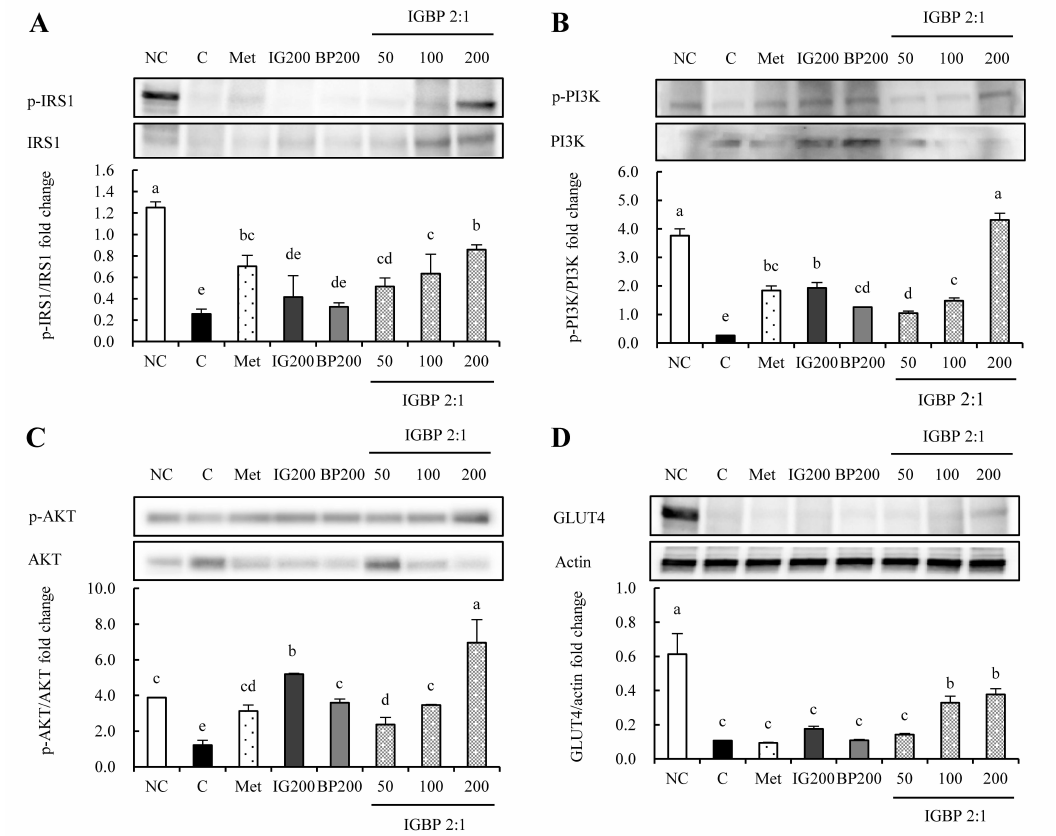
Figure 3. E ff ects of the IGBP 2:1 mixture on GLUT4 signaling-related proteins in 3T3-L1 adipocytes: ( A ) p-IRS1 / IRS expression ratio, ( B ) p-PI3K / PI3K expression ratio, ( C ) p-AKT / AKT expression ratio, and ( D ) GLUT4 expression. NC, normal control; C, di ff erentiated control; Met, metformin 1 mM; IG200, IG 200 µ g / mL; BP200, BP 200 µ g / mL; IGBP 2:1 (50, 100, or 200 µ g / mL). The resulting values are shown as mean ± standard deviation (SD; n = 3), and the di ff erent superscript letters (alphabet) indicate significance at p <